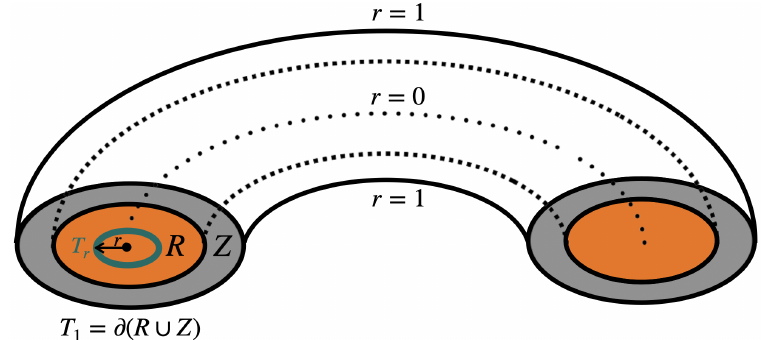
Figure 5 . Geometric configuration that facilitates solving for ∇ × A = B inside the ring. The surfaces of constant r foliate the ring with topological torus T r